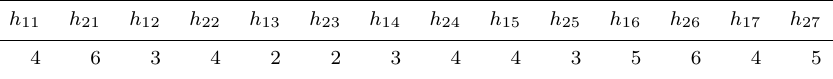
Table 5. Over time values in